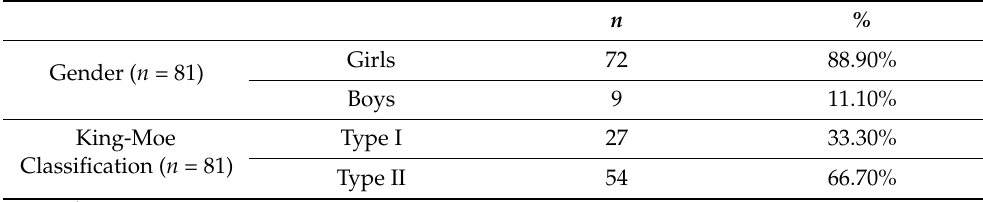
Table 1. Gender and type of scoliosis.